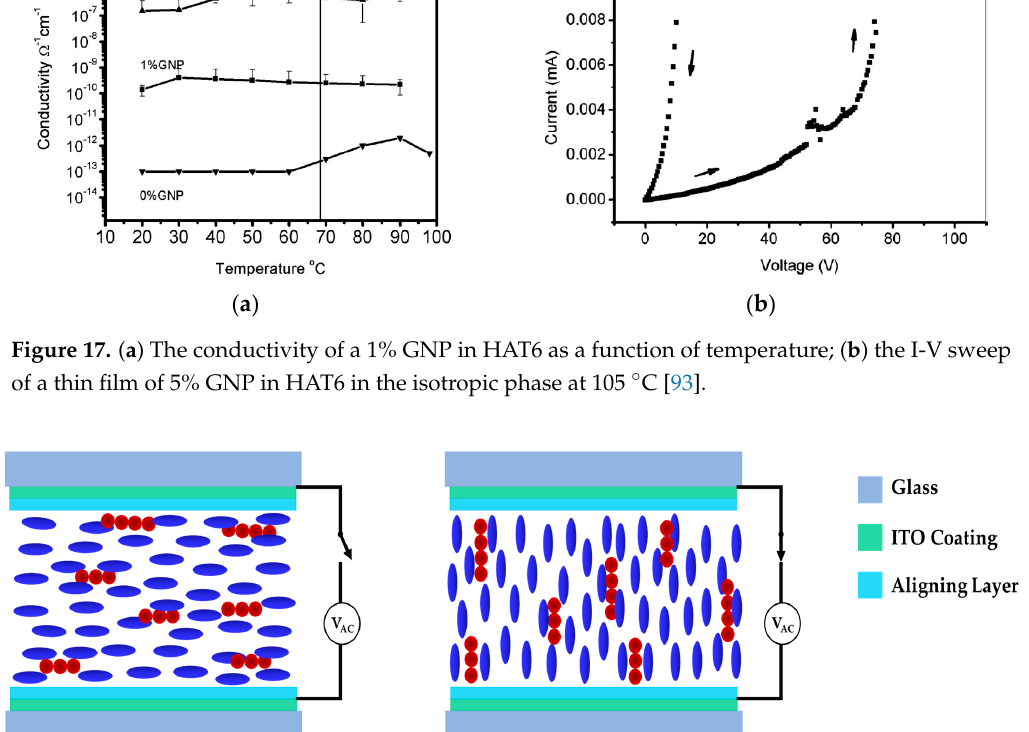
Figure 17. ( a ) The conductivity of a 1% GNP in HAT6 as a function of temperature; ( b ) the I-V sweep